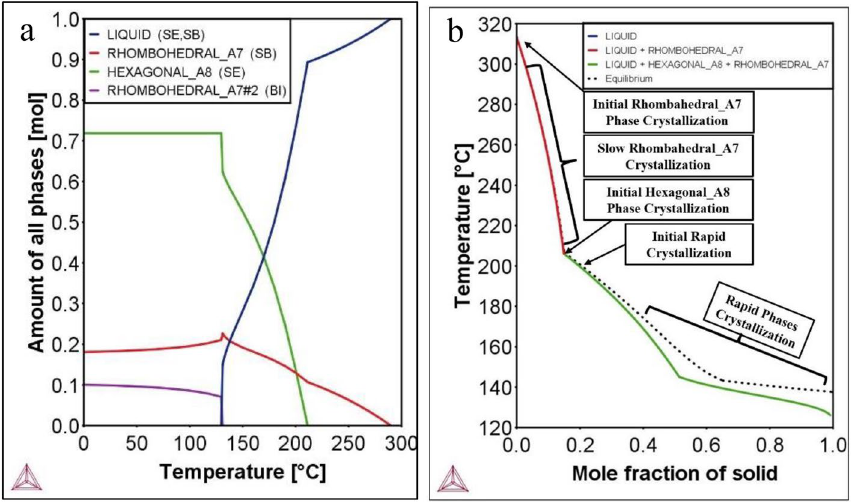
Figure 4. Material phase properties of BSTS. ( a ) Line plot of the phase concentrations versus temperature. ( b ) Scheil simulation.